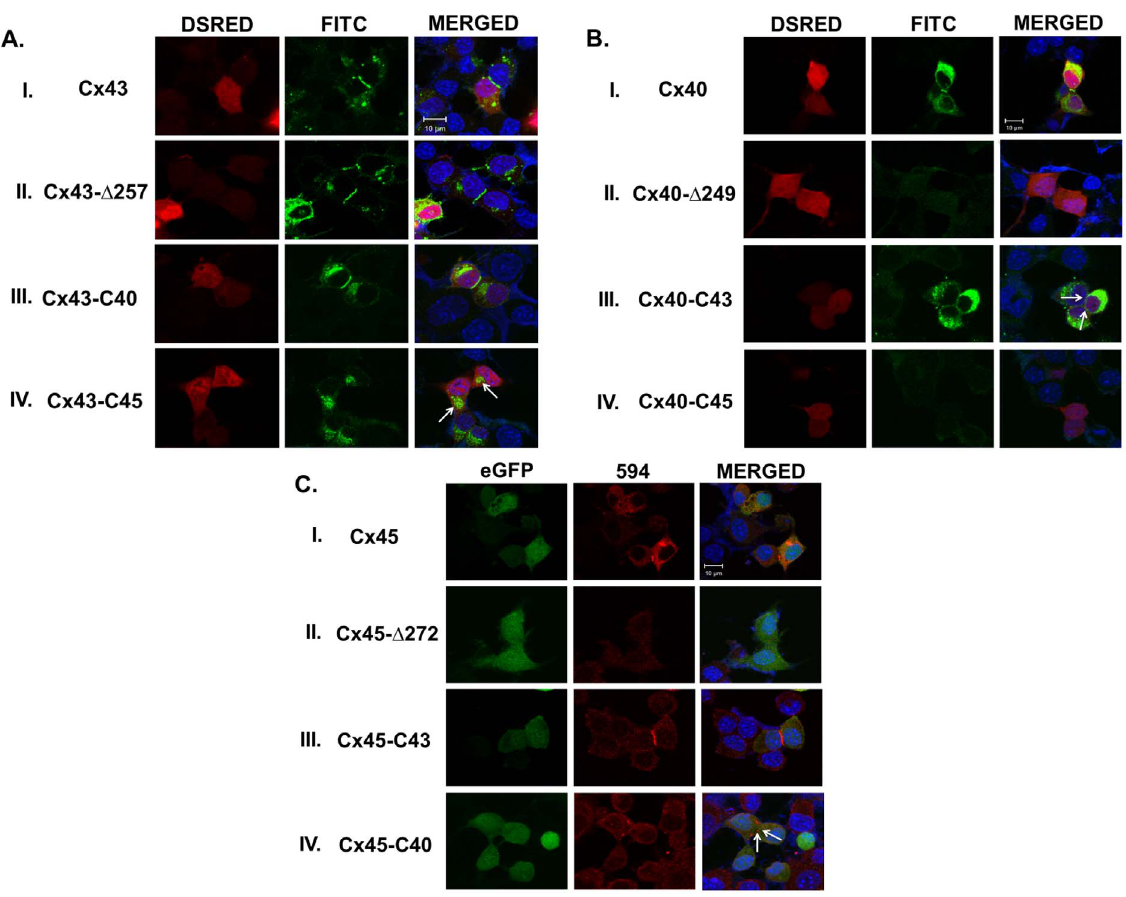
Figure 8. Carboxy terminal (CT) domain of connexins, regulate junctional plaque formation. A . I, II, III and IV are the representative confocal microscopic images of N2a cells expressing Cx43, Cx43- D 257, Cx43-C40 and Cx43-C45 respectively. Junctional plaques formed by Cx43- D 257 were significantly bigger (p , 0.05) than that of wild type Cx43. There was no significant difference in plaque diameter between Cx43-C40 and Cx43. Cx43-C45 did not form detectable plaque. Most of the connexins were detected in the perinuclear area (shown with white arrows). B . I, II, III and IV are the images of Cx40, Cx40- D 249, Cx40-C43 and Cx40-C45 expressing cells respectively. Cx40- D 249 plaques were not detectable. Plaques formed by Cx40-C43 were thin and punctuated (shown with white arrows). Cx40-C45 did not form detectable plaque. C . I, II, III and IV, images of Cx45, Cx45- D 272, Cx45-C43 and Cx45-C40 transfected N2a cells respectively. Cx45- D 272 junctional plaques were not detectable. Cx45-C43 plaques were significantly larger than corresponding Cx45 plaques. Cx45-C40 plaques were punctuated and smaller compared to wild type Cx45.